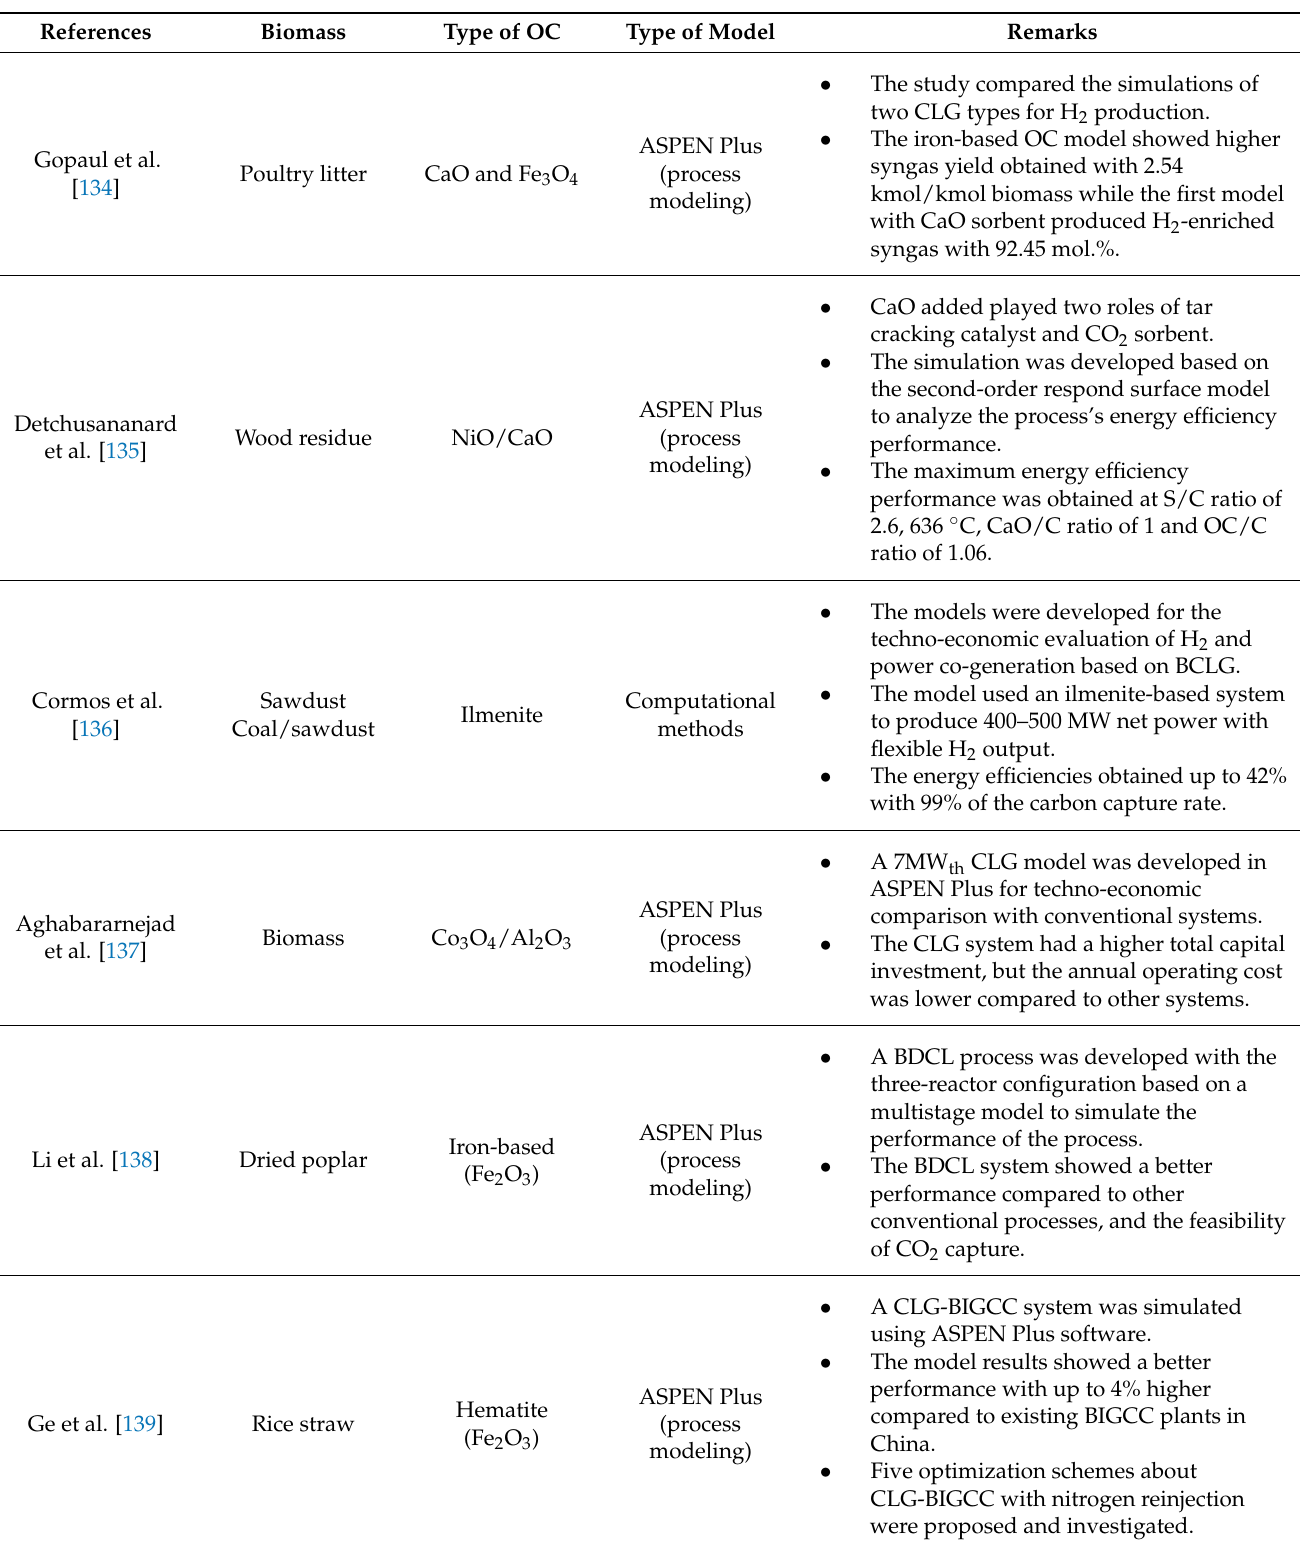
Table 7. Summary of the key information of recent simulation studies in